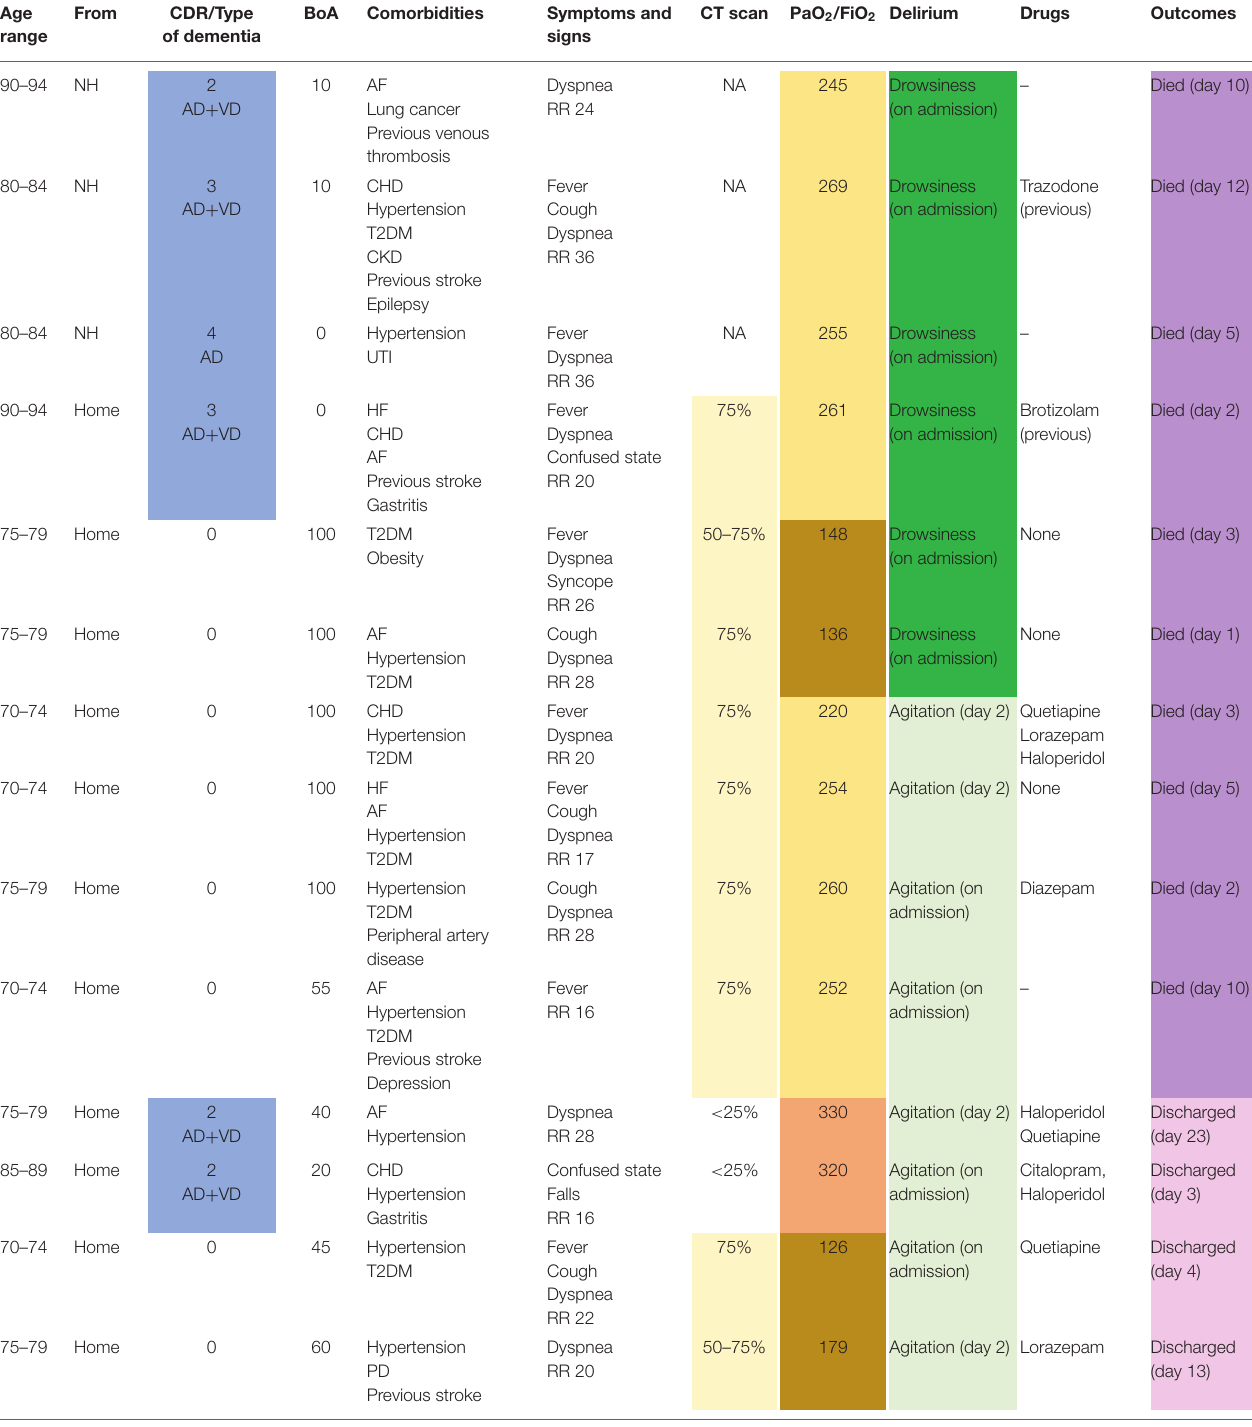
TABLE 1 | Characteristics and outcomes of 14 older patients with confirmed diagnosis of COVID-19 and delirium. Age From CDR/Type BoA Comorbidities Symptoms and CT scan PaO 2 /FiO 2 Delirium Drugs range of dementia signs